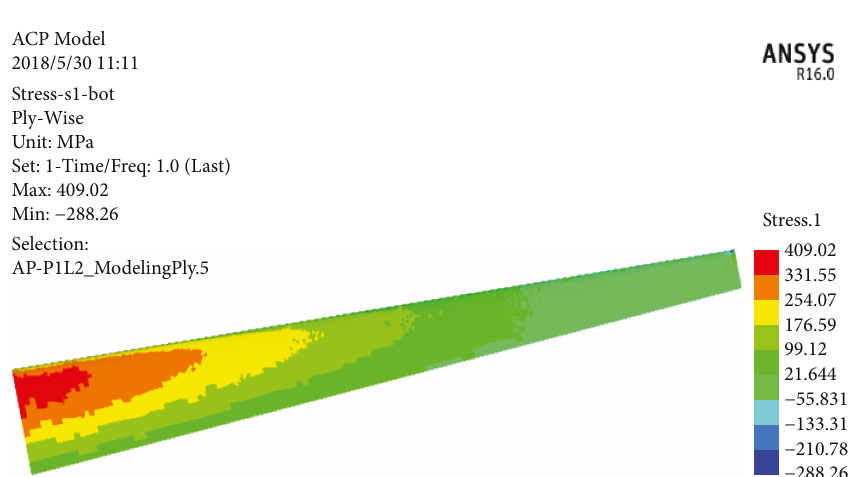
Figure 19: Stress cloud diagram of the lower wing with the layer sequence being [0/45/90/-45/0]